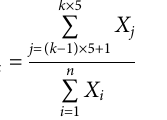
Frontiers in Environmental Science |